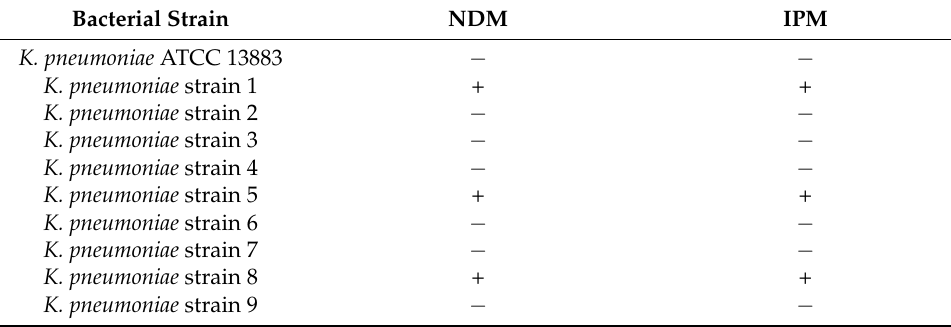
Table 3. Prevalence of NDM and IPM genes in the Kp tested